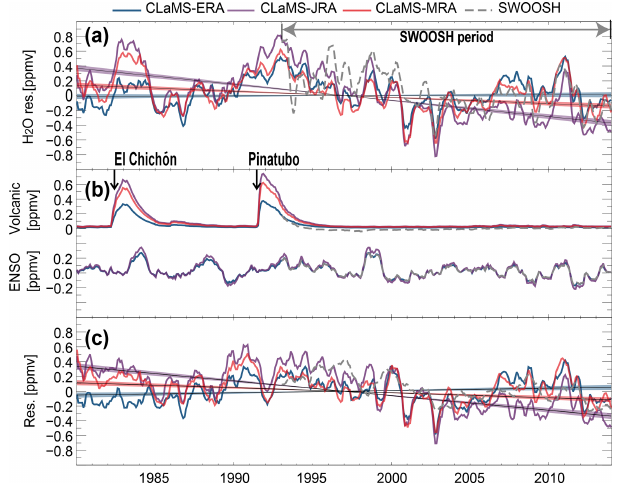
Figure 9. Comparison of residual variability after removing the AC, QBO and SAH from H 2 O entry values (mean H 2 O mixing ratios on θ = 400K averaged over 20 ◦ S–20 ◦ N) based on CLaMS sim- ulations and SWOOSH. Panel (a) shows the residual term ( χ res ) after applying a 3-month running mean. The long-term linear fit is plotted as a solid line with ± 2 σ uncertainties. Panel (b) shows ad- ditional components of the multiple linear regression, including the influences of variations in volcanic aerosol (upper set of lines) and ENSO (lower set of lines). Panel (c) shows the residuum of (a) after subtracting all contributors shown in (b) , along with the correspond- ing